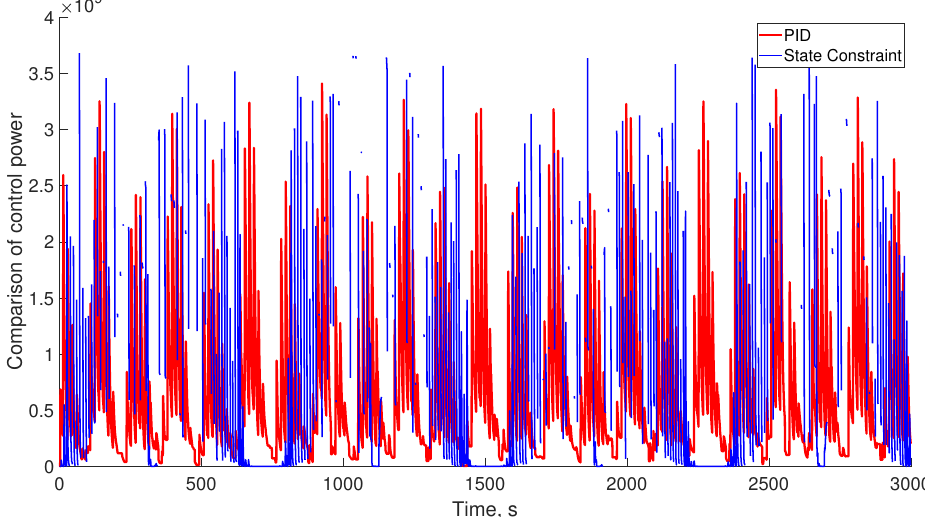
Figure 8. Comparison of control action between the proposed state constraint and the traditional state feedback control